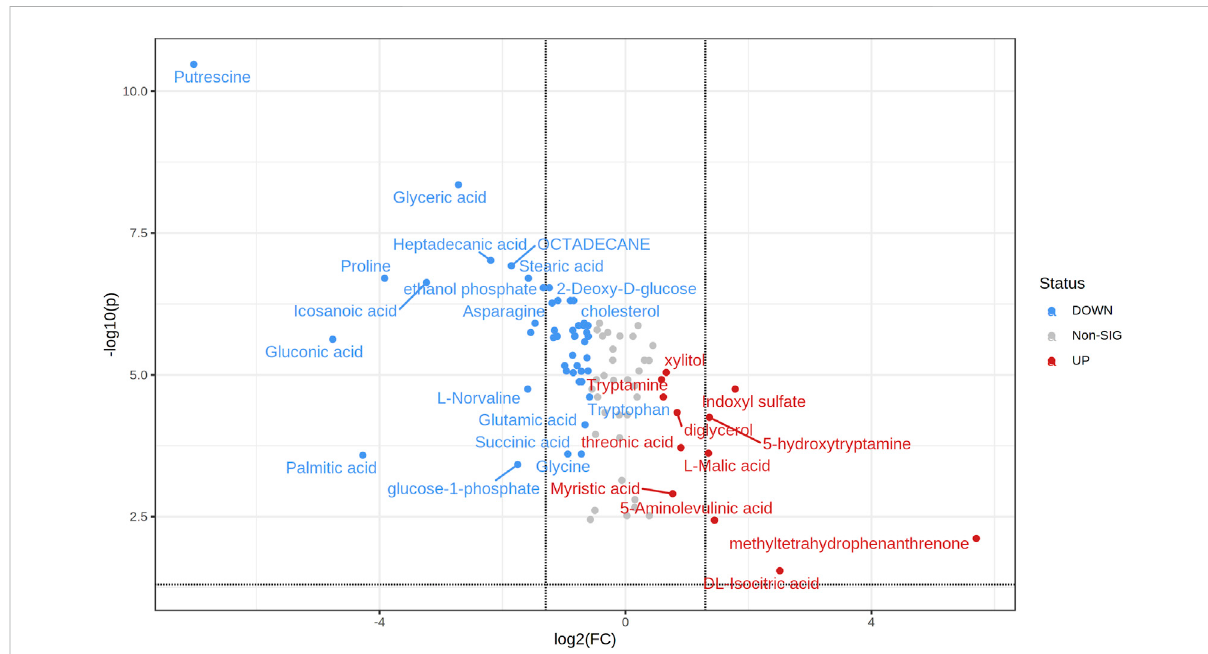
FIGURE 4 Important features selected by volcano plot with fold change threshold (x) 1.5 and FDR corrected t-tests threshold (y) P ≤ 0.05. The red (up- accumulated) and blue (down-accumulated) circles represent features above the threshold. Note both fold changes and p values are log transformed. The further its position away from the (0,0), the more signi fi cant the feature is. (N = 50 OSA and 30 =